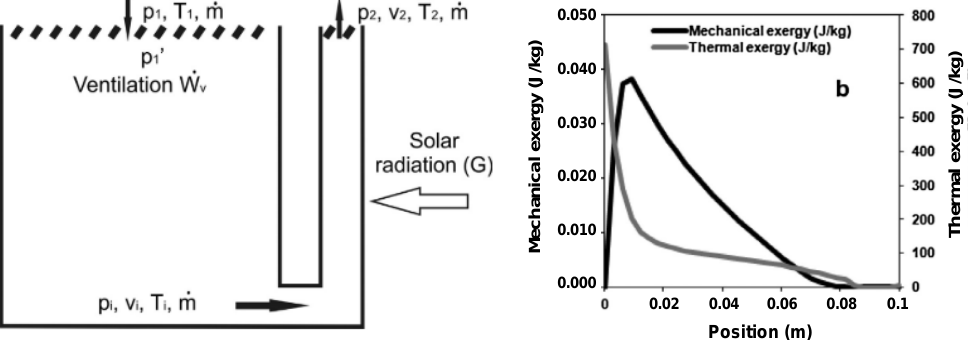
Figure 12. Left-hand figure: Schematic of the variables used in the analysis. Right-hand figure: Mechanical and thermal exergy values at the exit section of the solar chimney for various distances from the symmetry plane [44].